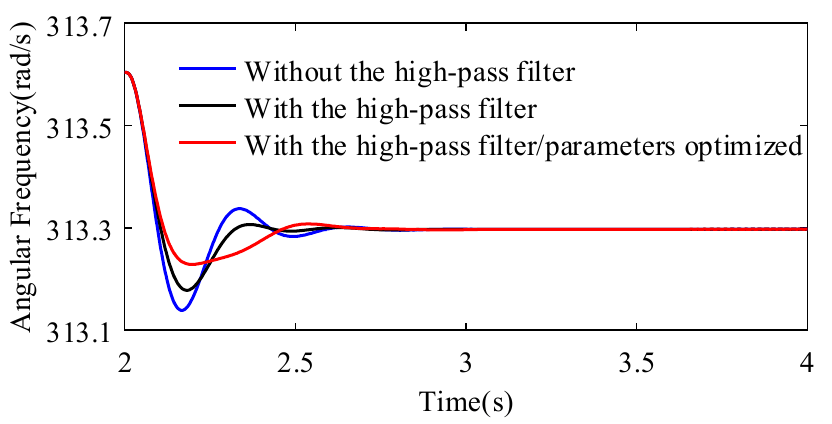
Figure 14. The simulation result of SG angular frequency with the asynchronous motor load.